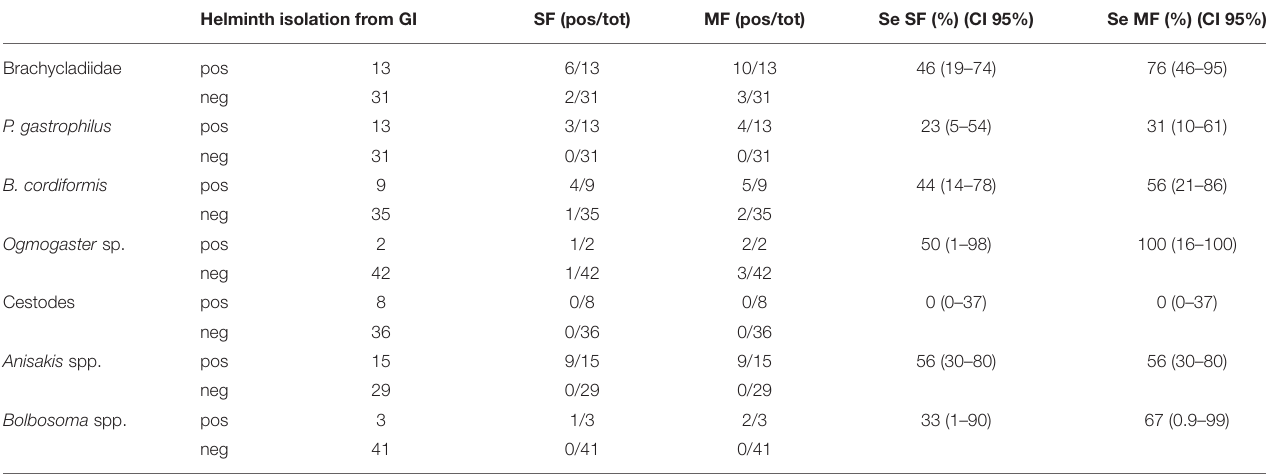
TABLE 3 | Comparison of the results of SF and MF methods with isolation of corresponding helminthic taxa from the stomach/intestine and calculation of their sensitivity. Helminth isolation from GI SF (pos/tot) MF (pos/tot)